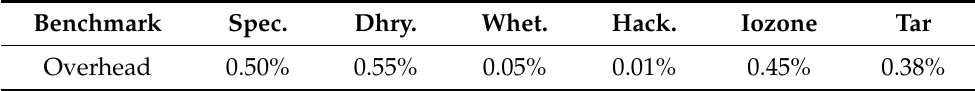
Table 4. Performance overhead for application benchmarks.